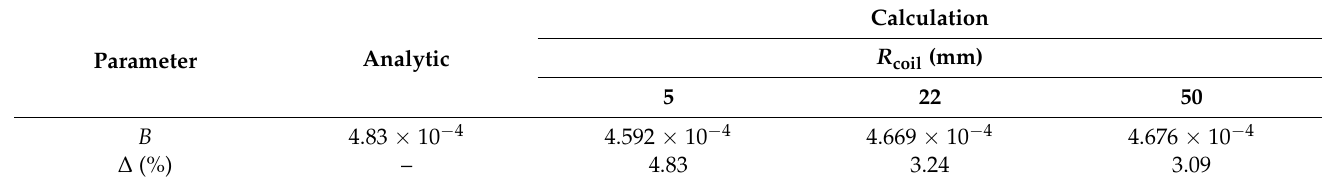
Table 3. The fiber